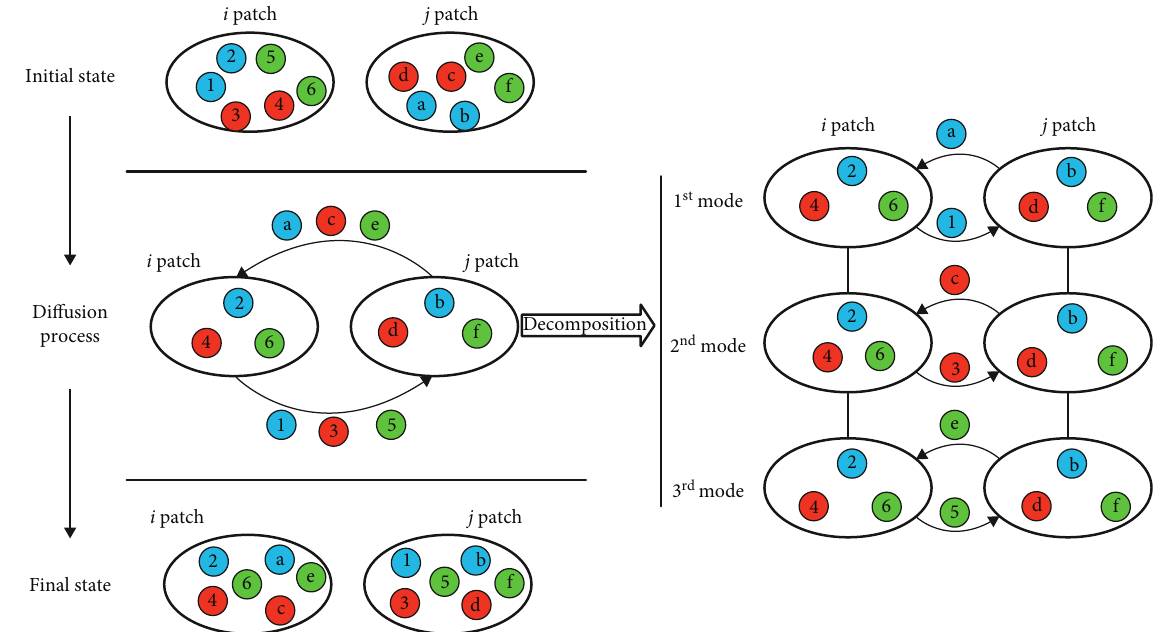
Figure 1: Individuals’ travelling map with three travelling modes in two subpopulations. Initially, there are six individuals belonging to region i and region j , respectively. The individuals with the same color own the same travelling